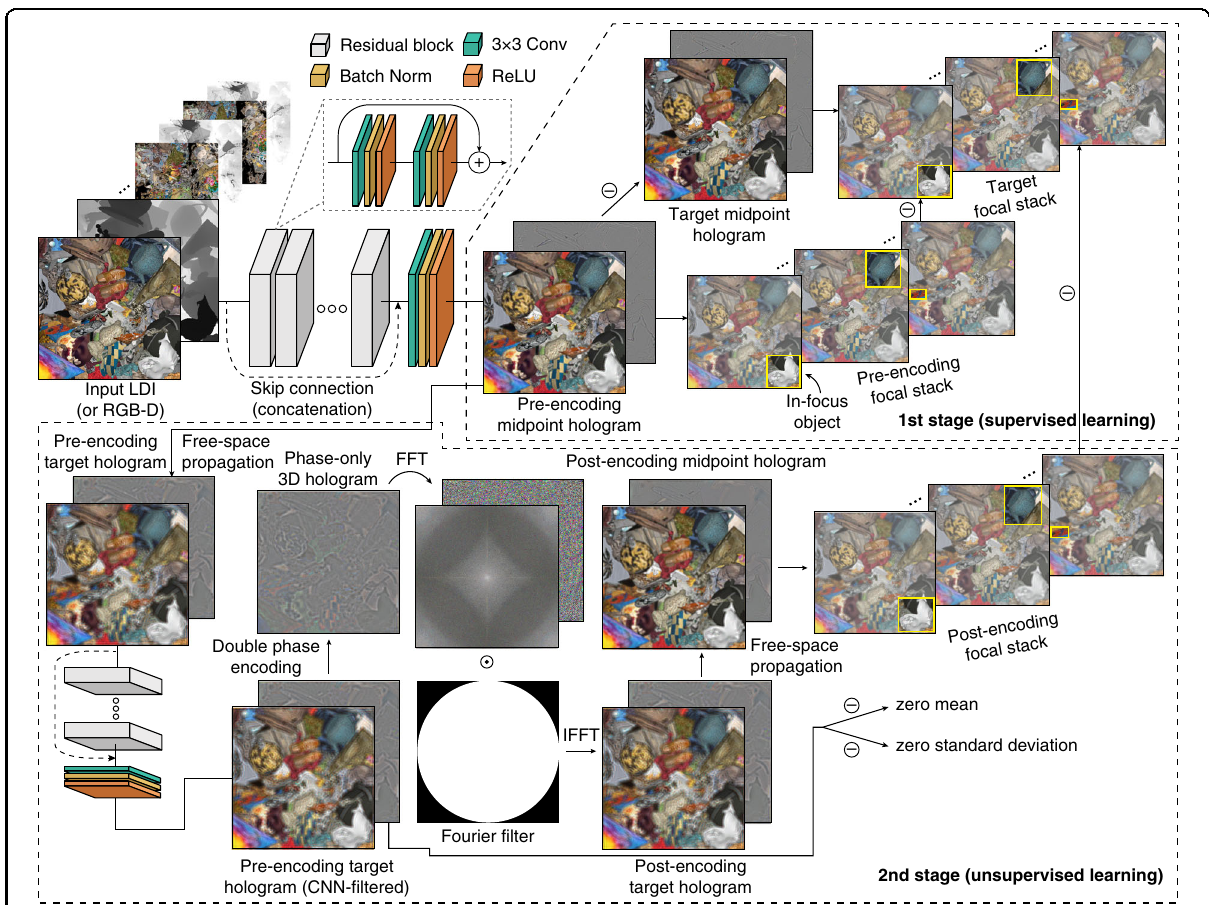
Fig. 3 Overview of the training procedure. In the fi rst stage, the CNN is trained to reproduce the ground truth midpoint hologram with direct supervision and a dynamic focal stack loss. In the second stage, the CNN prediction is propagated to the target hologram plane, fi ltered by a second CNN, double phase encoded, Fourier fi ltered, and back propagated to the center of the 3D volume to obtain the post-encoding midpoint hologram. No ground truth phase-only hologram is provided, and the CNN is trained to discover an optimal solution with the dynamic focal stack loss between the post-encoding focal stack and the target focal stack plus a regularization loss (see Eq. (11)). The Fourier space amplitude is visualized in